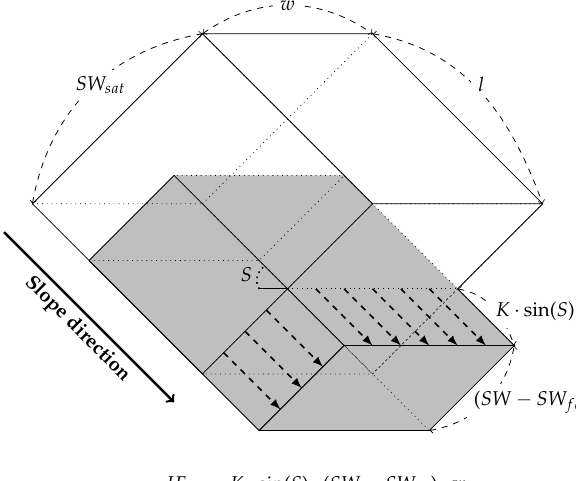
Figure 3. Conceptual representation of interflow in an element (modified from Figure 3 of Choi et al. [39]). transferable soil water for interflow ( SW the volume of interflow from the element ( IF out ) can be represented as K and cannot exceed the volume of the transferable soil water of the element ( ( SW